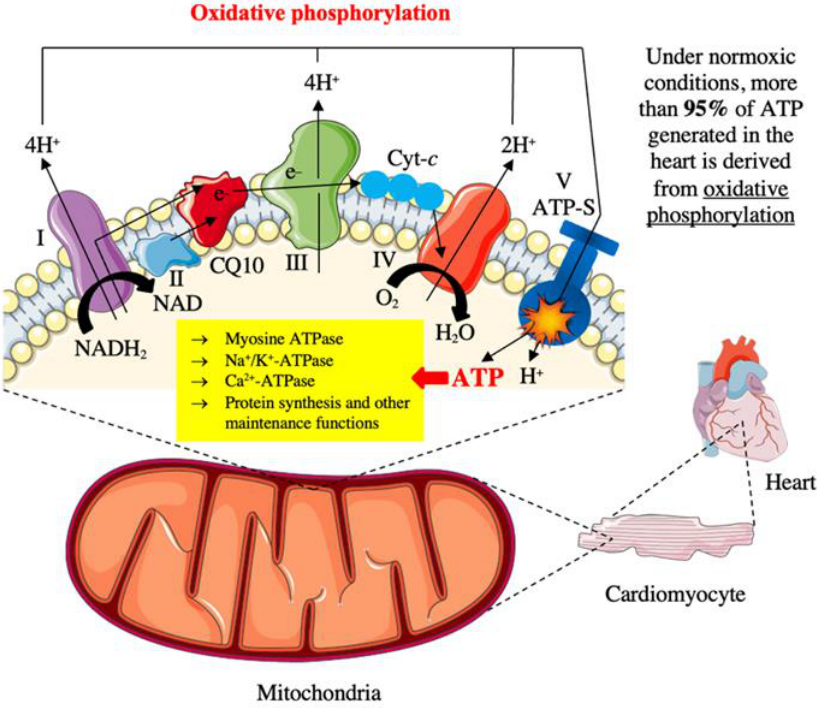
Figure 3. The role of coenzyme Q10 in the energy metabolism of the heart muscle. NADH 2 /NAD — nicotinamide-adenine dinucleotide (reduced/oxidized); CQ10 — coenzyme Q10; Cyt- c — cytochrome c; ATP-S — ATP synthase; ATP — adenosine triphosphate.